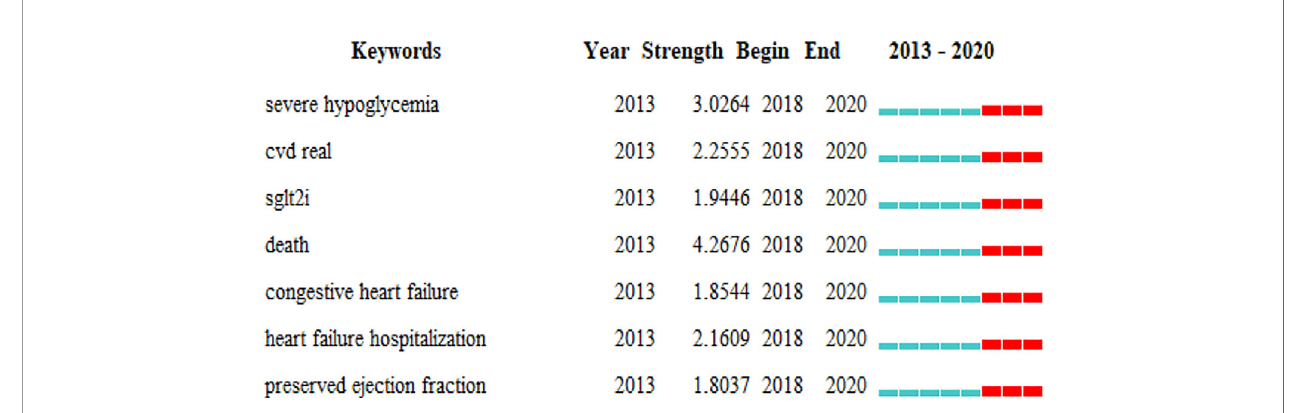
FIGURE 7 | Keywords with periods of burst from 2018 onward among the top 100 burst keywords in articles related to SGLT2 inhibitors in